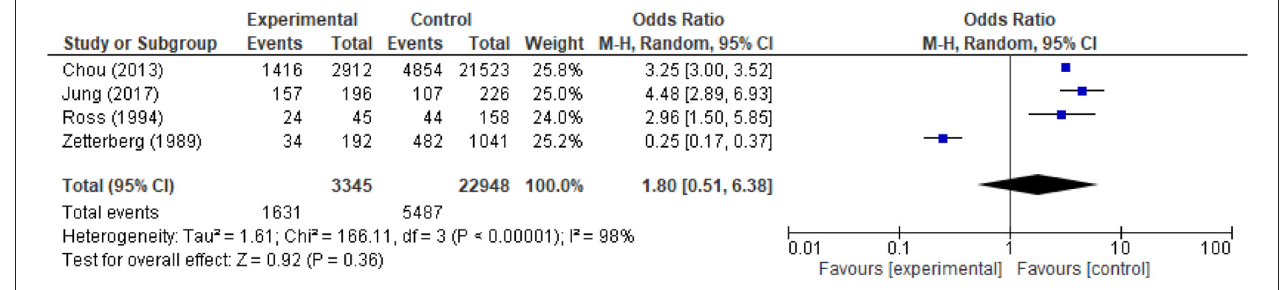
FIGURE 2 | Odds of pain in patients with fracture.